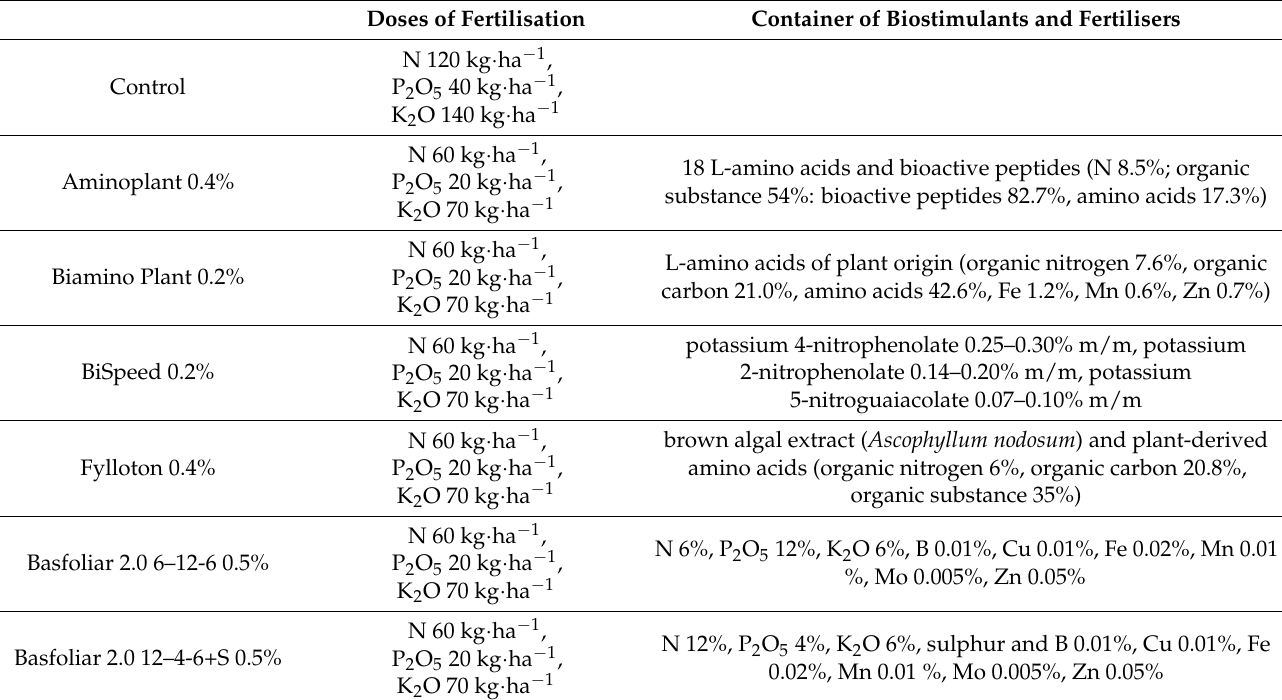
Table 1. Treatments used in the